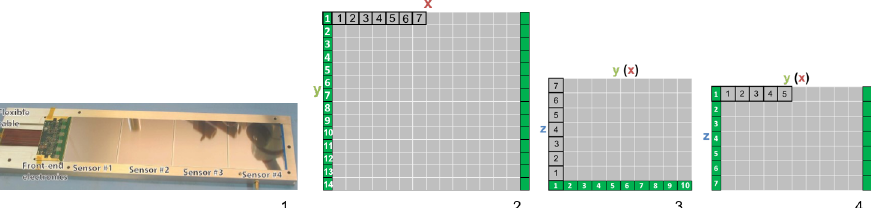
Figure 4. DAMPE ladder equipped with 4 SSDs made by Hamamatsu with an area of 95 mm × 95 mm (1). Sketch of a top STK plane equipped with 28 Type A ladders (2). Sketch of a lateral STK plane equipped with 10 Type A ladders (3). Sketch of a lateral STK plane equipped with 14 Type B ladders (4).